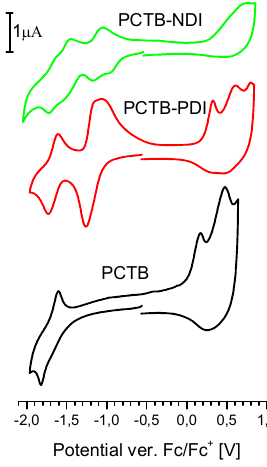
Figure 2. Cyclic voltammetry of polymer films spin coated on ITO electrode with ACN/Bu 4 NBF 4 as supporting electrolyte.